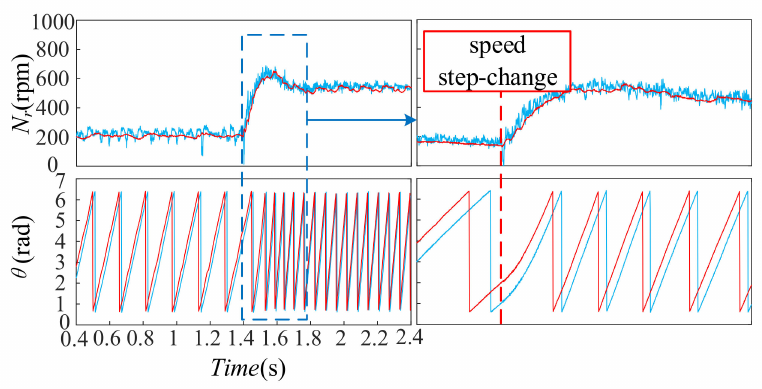
Figure 13. Tracking performances of speed and position during the speed step-change (the red line represents the actual value, and the blue line represents the estimated value).